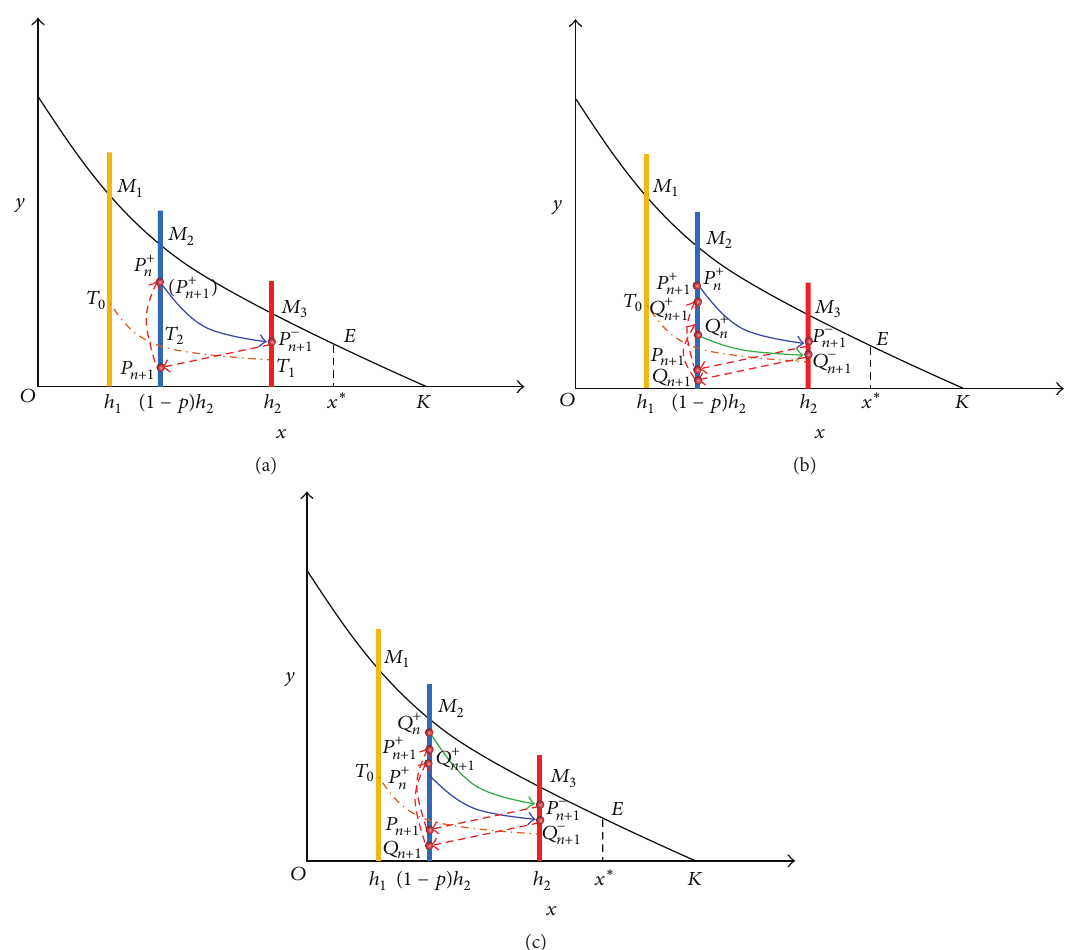
Figure 2: The trajectory of system (1) when (1 − 𝑝)ℎ 2 is greater than ℎ 1 . (a) 𝑃 + 𝑛+1 overlaps with 𝑃 + 𝑛 ; (b) 𝑃 + 𝑛+1 is under 𝑃 + 𝑛 ; (c) 𝑃 + 𝑛+1 is above 𝑃 + 𝑛 .